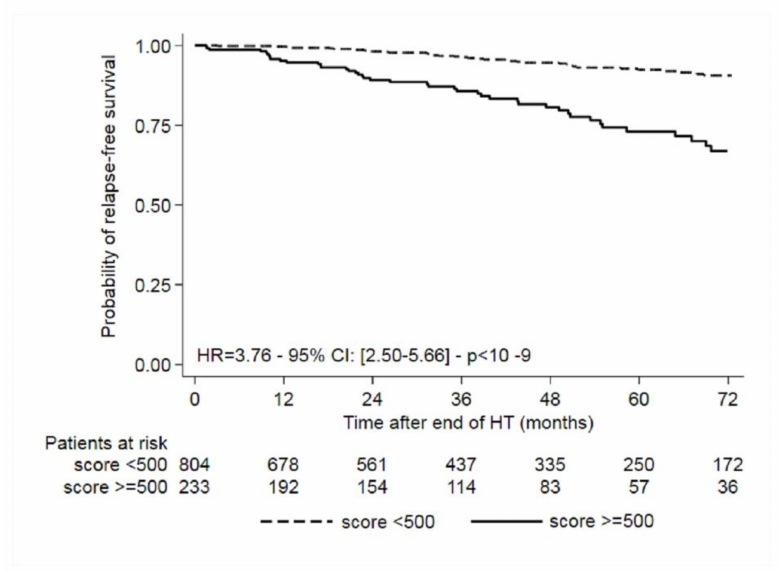
Figure 2. Probability of relapse-free survival according to low- and high-risk